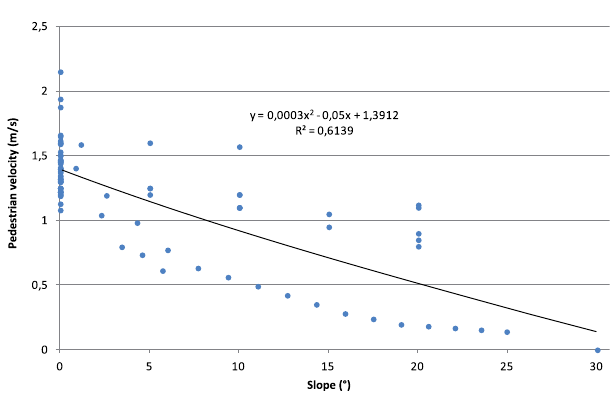
Fig. 5. Pedestrian velocity depending on the slope: bibliographic synthesis and function